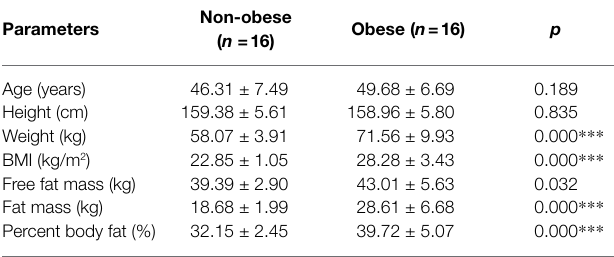
TABLE 1 | Participants’